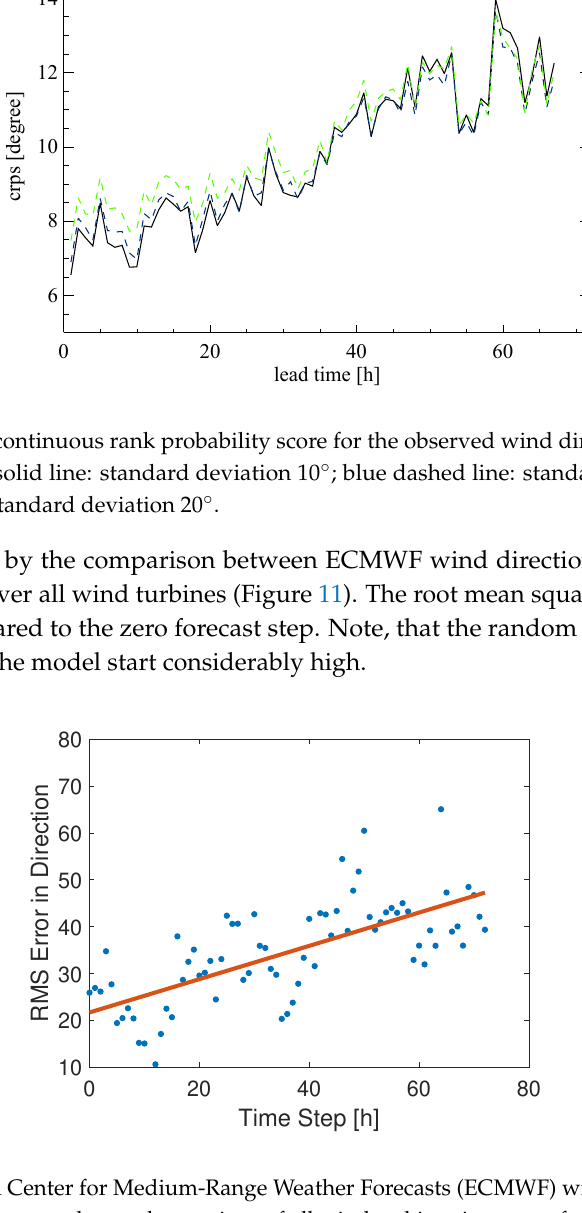
Figure 11. European Center for Medium-Range Weather Forecasts (ECMWF) wind direction forecasts skill validated with averaged yaw observations of all wind turbines in terms of root mean square